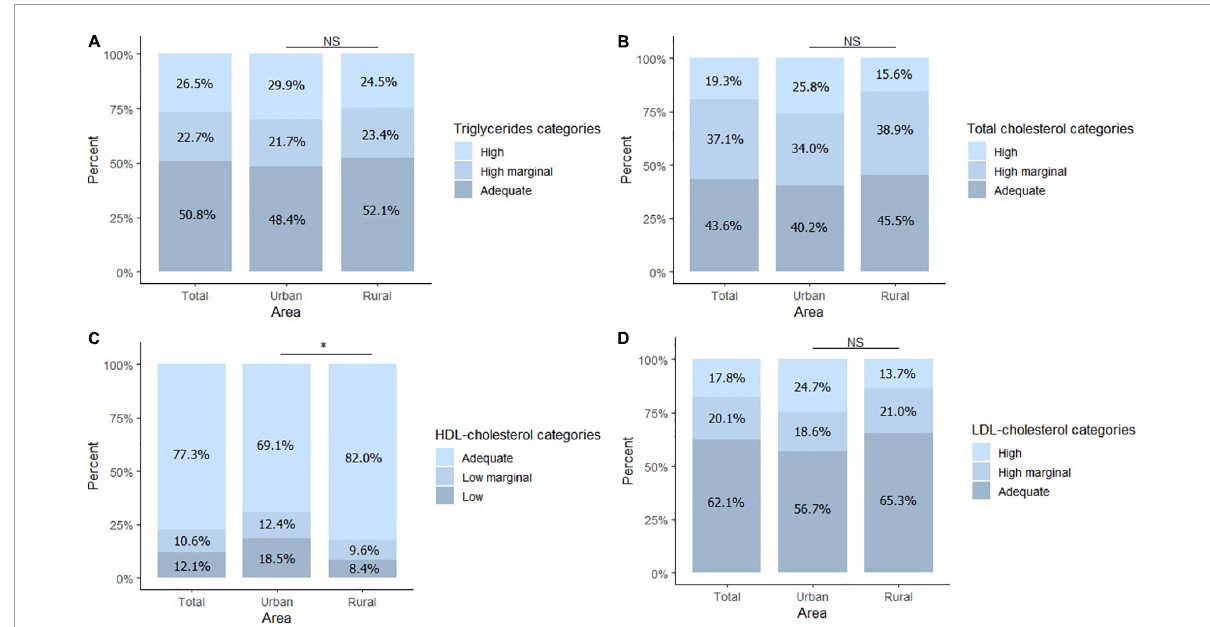
FIGURE2 Blood lipid profile. (A) Percentage of children within high, marginal high, and adequate values for triglycerides. (B) Percentage of children within high, marginal high, and adequate values for total cholesterol. (C) Percentage of children within low, marginal low, and adequate values for HDL-cholesterol. (D) Percentage of children within high, marginal high, and adequate values for LDL- cholesterol. Total n = 264, Urban n = 97, Rural n = 167. ∗ P < 0.05. NS, no significant